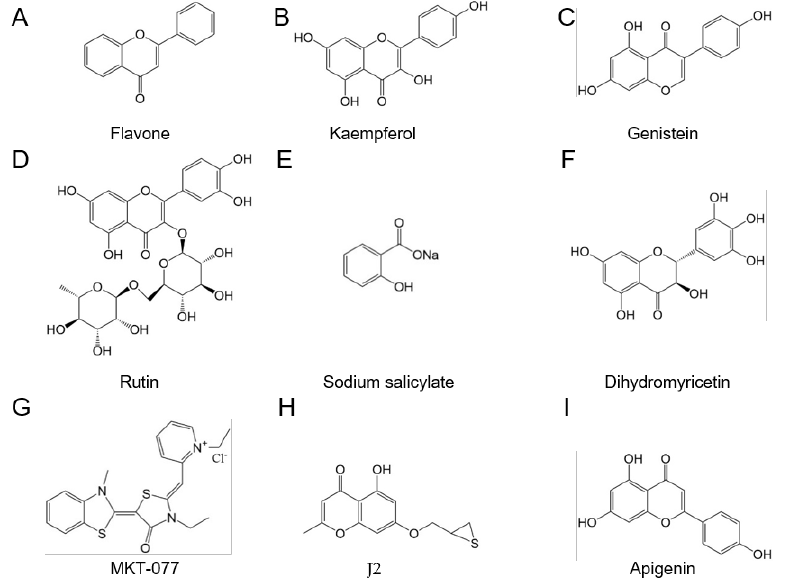
Figure 7. The molecular structure of flavonoids or other HSP inhibitors with the activity of HSP inhibition. ( A ) Flavone. ( B ) Kaempferol. ( C ) Genistein. ( D ) Rutin. ( E ) Sodium salicylate. ( F ) Dihydromyricetin. ( G ) Rhodacyanine-based (MKT-077). ( H ) Chromone analogs possessing thiiran-2-ylmethoxy or oxyran-2-ylmethoxy substituents. ( I ) Apigenin.